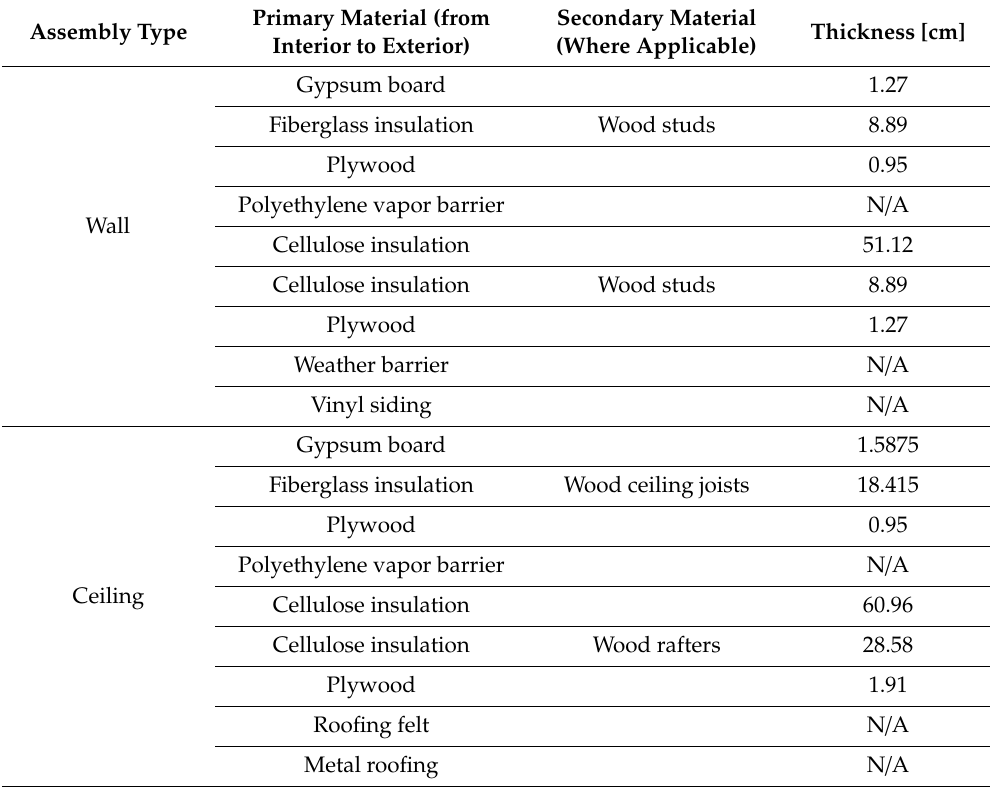
Table 1. Stratigraphies of the wall and ceiling